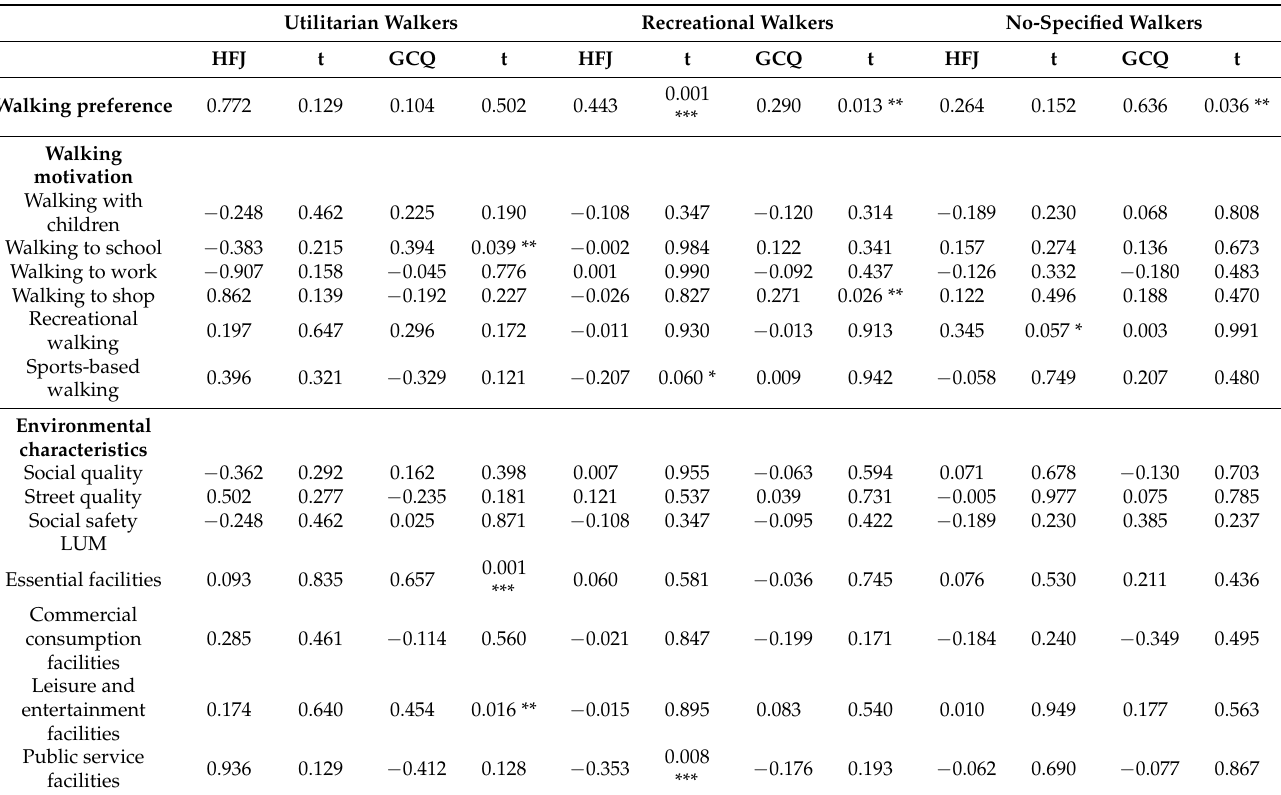
Table 8. Correlation analysis of daily walking time and multiple factors of different walker types on two